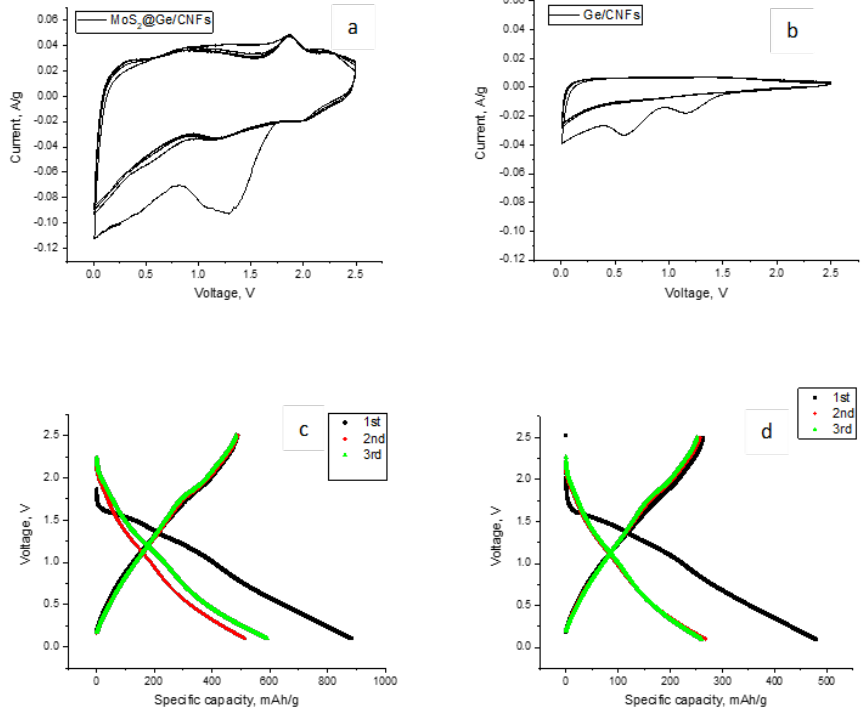
Figure 4. First cycle CV curves and charge–discharge curves of: ( a , c ) MoS 2 @Ge/CNFs and ( b , d ) Ge/CNFs.